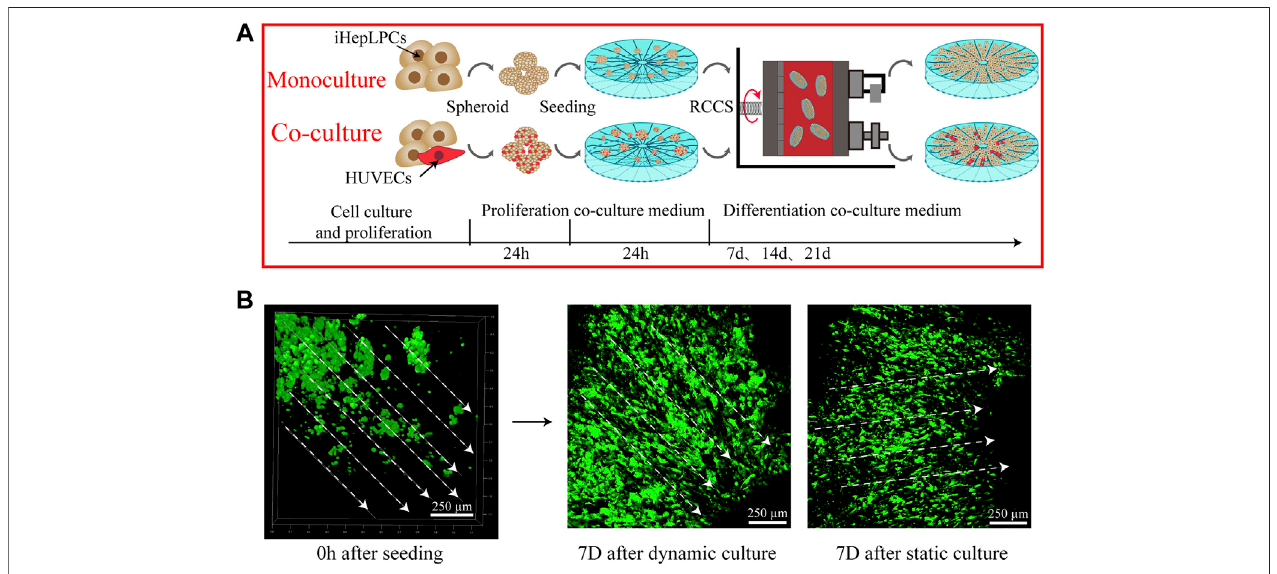
FIGURE 4 | A schematic showing the construction process of hepatic lobule-like cultures (A) . Distribution and morphological changes in iHepLPCs (GFP- transfected) after dynamic or static culture conditions (B) are shown.